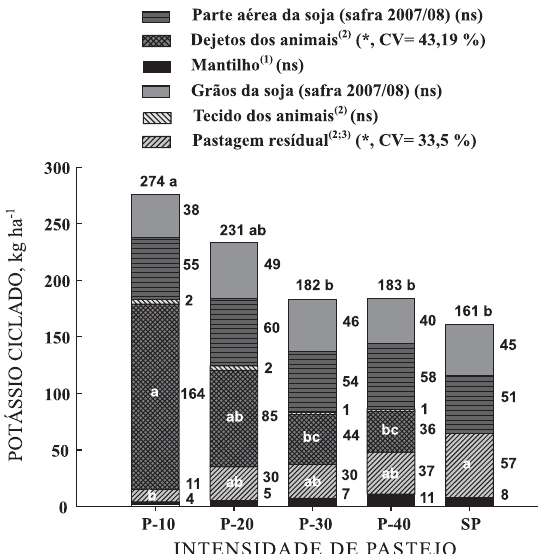
Figura 3. Potássio ciclado em compartimentos da pastagem, da soja e dos animais em um ciclo de sistema de integração lavoura-pecuária submetido a intensidades de pastejo (10, 20, 30 e 40 cm de altura do pasto - P-10, P-20, P-30 e P-40, respectivamente) e sem pastejo (SP). (1) Palhada remanescente da soja e da pastagem. (2) A soma desses três compartimentos representa o total de K ciclado pela pastagem acumulada durante todo o ciclo de pastejo (K ingerido pelos animais (K dos dejetos + K do tecido) + K da pastagem residual), que foram de 177, 117, 75, 74 e 57 kg ha -1 para os tratamentos P-10, P-20, P-30 e P-40 cm e SP, respectivamente. (3) Parte aérea da pastagem no final do seu ciclo. *, n.s.: significativo a 5 % e não significativo pelo teste F (p < 0,05), respectivamente. Médias seguidas pela mesma letra, em cada compartimento e no total, não diferem entre si pelo teste de Tukey a 5